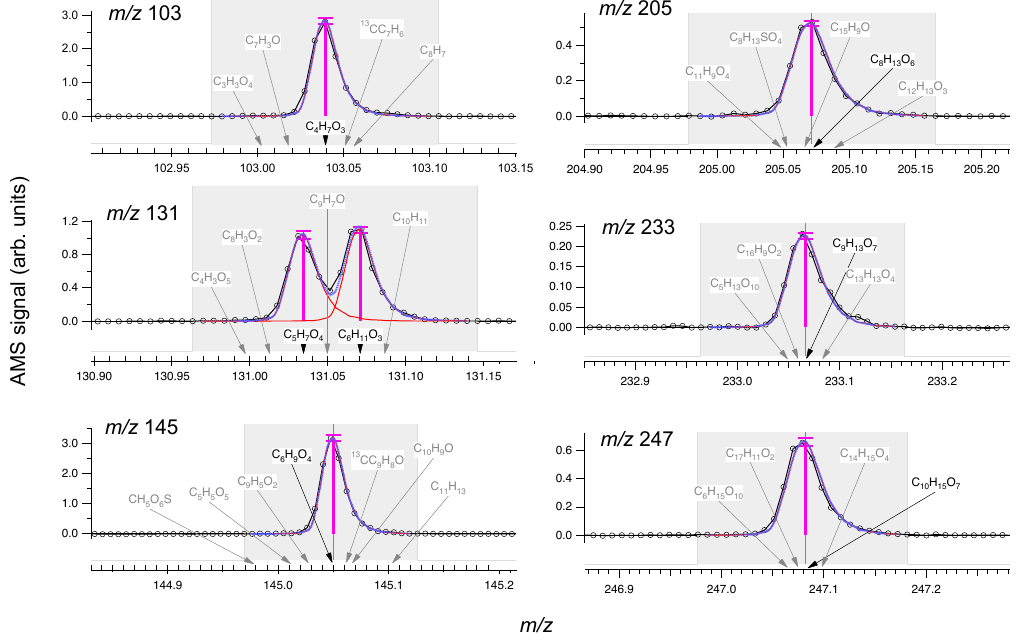
Fig. 9. High-resolution W-mode AMS peaks of a number of the major fragment ions observed in methacrolein/high-NO 2 experiments. Knowledge of the accurate masses allow assignments of molecular formulas, corresponding to loss of hydroxyl groups from compounds detected by offline analysis, suggesting that detection of compounds listed in Table 3 is not a result of sampling artifacts. m/z 131 contains two different ions, only one of which is consistent with compounds detected by offline UPLC/(–)ESI-TOFMS